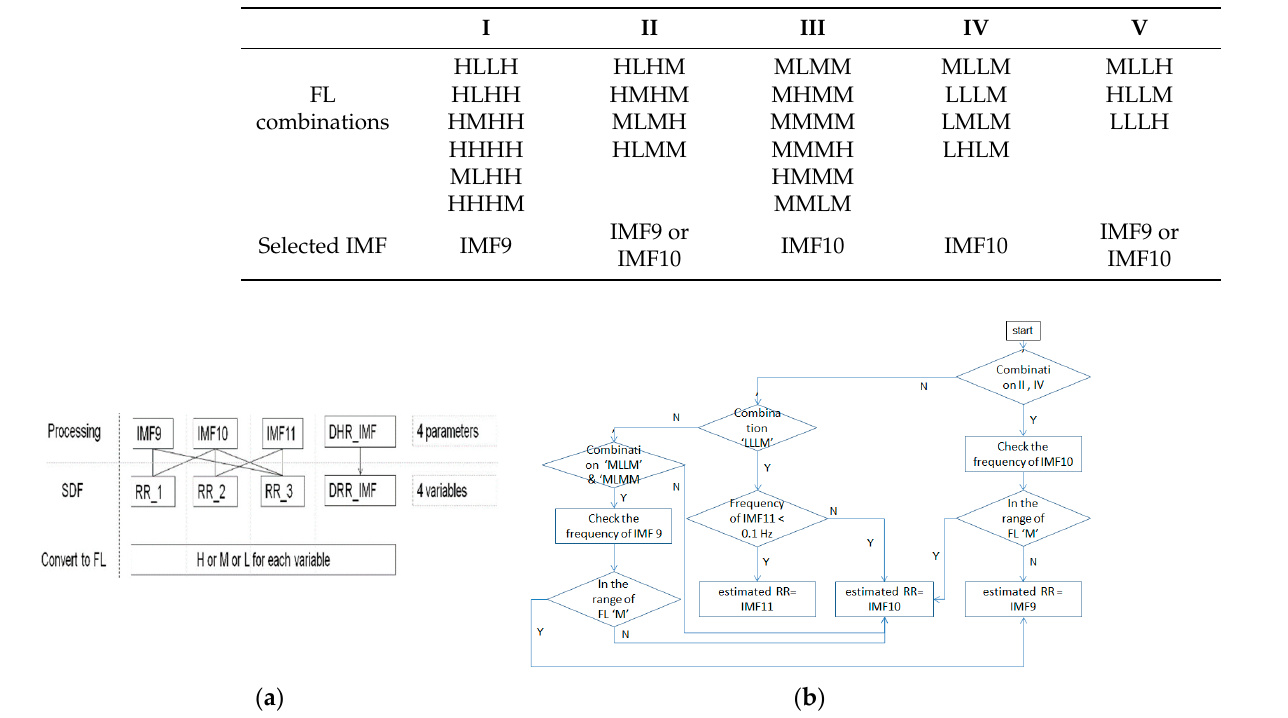
Table 3. The selection rule using combinations of frequency level.